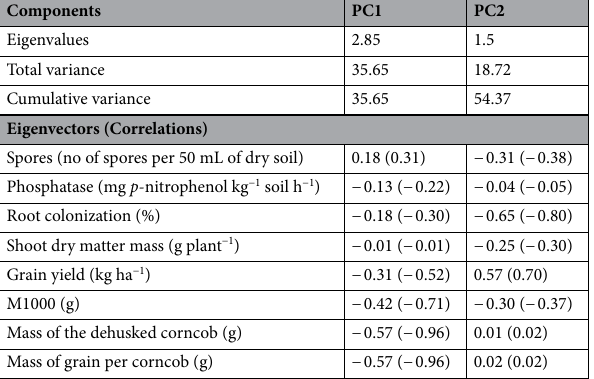
Table 5. Eigenvalues, total and cumulative variance, eigenvectors, correlation coefficients and the two first principal components for the variables related to acid phosphatase, mycorrhizal symbiosis and the yield components in the 2019 crop. PC1 principal component one, PC2 principal component two.